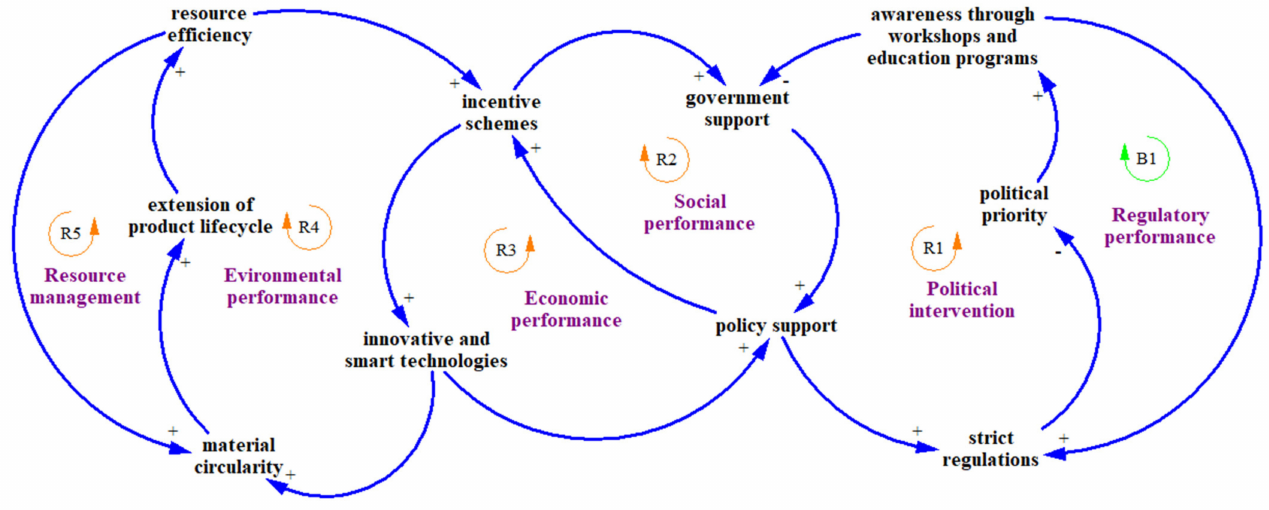
Figure 4. Causal Loop